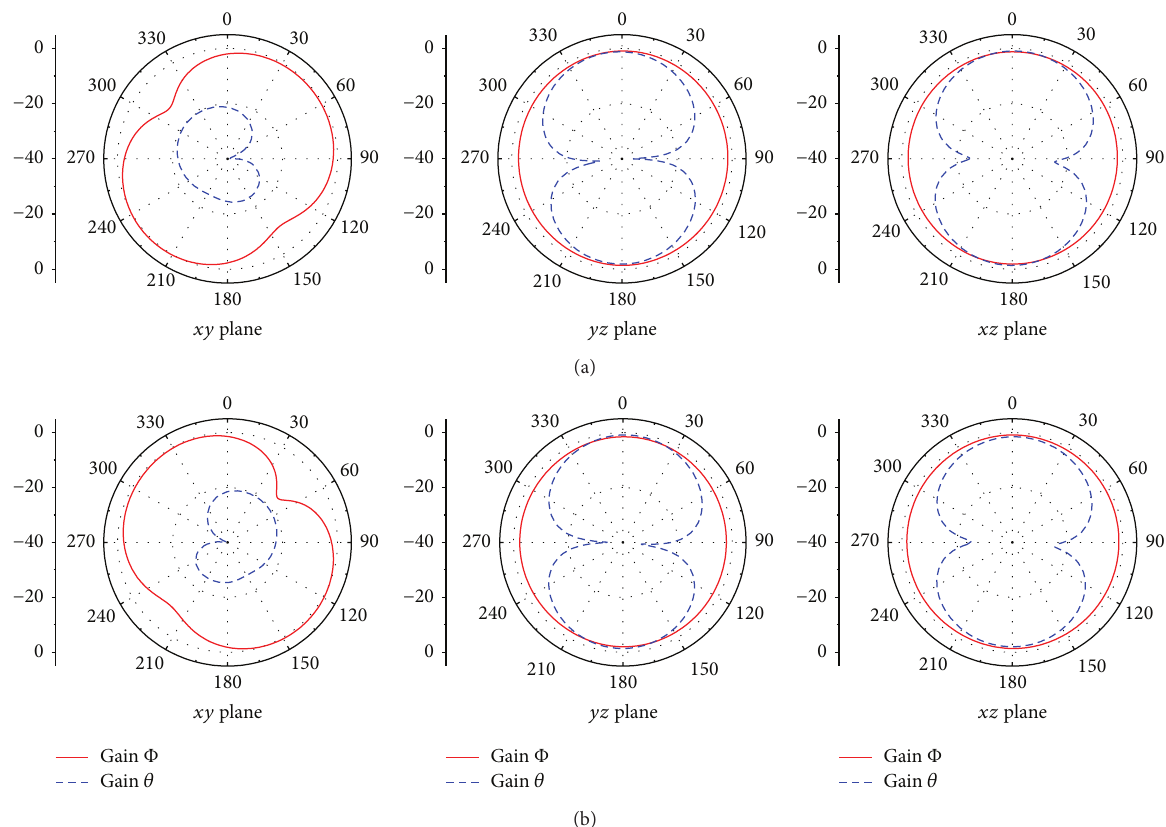
Figure 11: Radiation patterns of proposed metamaterial MIMO antenna at central frequency of 2.44 GHz when (a) excited Port 1 and (b) excited Port 2.